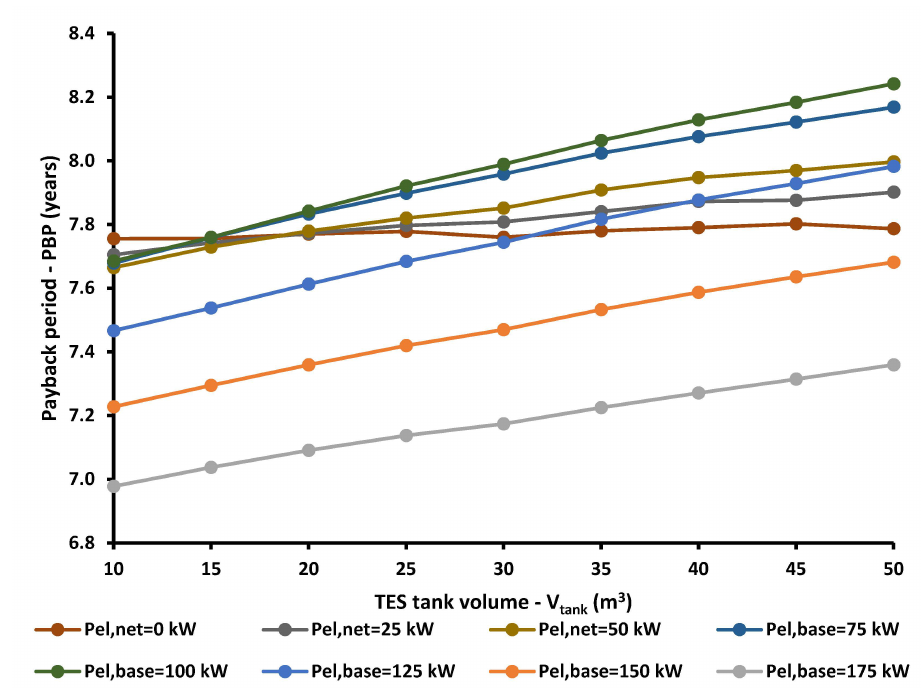
Figure 12. Payback period for different values of net electricity load and TES tank volume when the hydrogen price is equal to 20